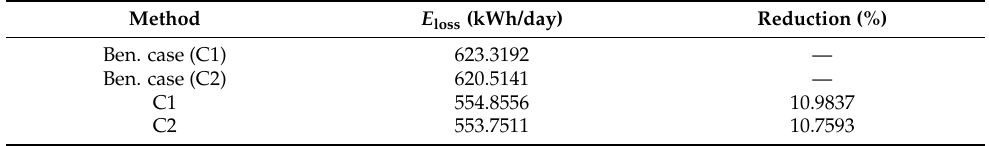
Table 7. Analysis of the simulation cases C1 and